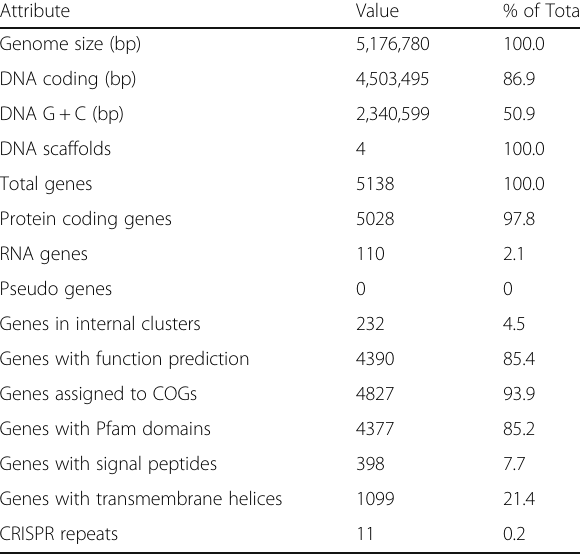
Table 4 Genome statistics